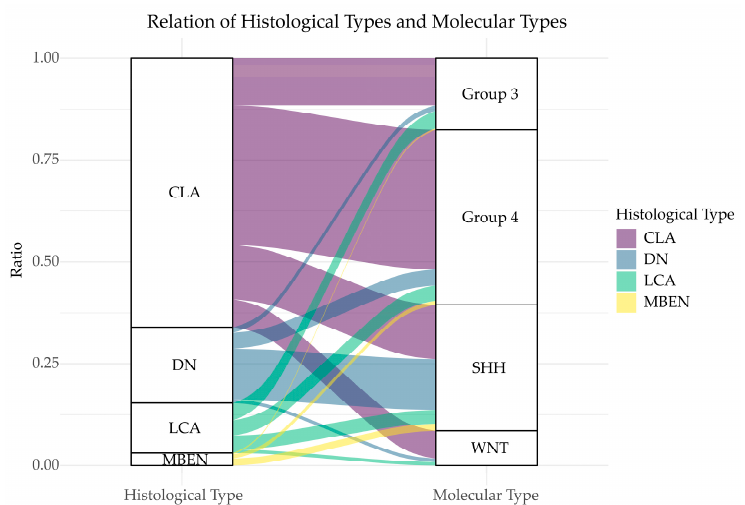
Figure 1. Relation of histological types and molecular types. The two columns represent histological classification and molecular classification, respectively. Different heights correspond to different ratios. Lines between the columns represent the overlapping classification systems. The broader a line, the more overlapping patients it has. This figure was made based on the date from the reference [12]. CLA: classic medulloblastoma; DN: desmoplastic/nodular medulloblastoma; LCA: large cell/anaplastic medulloblastoma; MBEN: medulloblastoma with extensive nodularity.